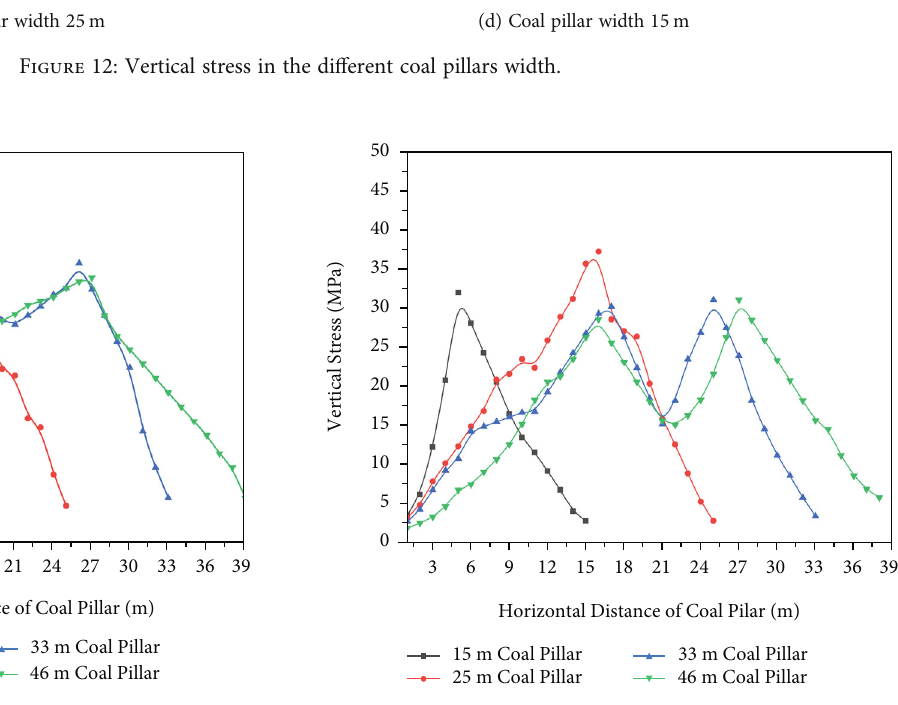
Figure 13: Vertical stress during di ff erent pillar driving. Figure 14: Vertical stress during di ff erent pillar